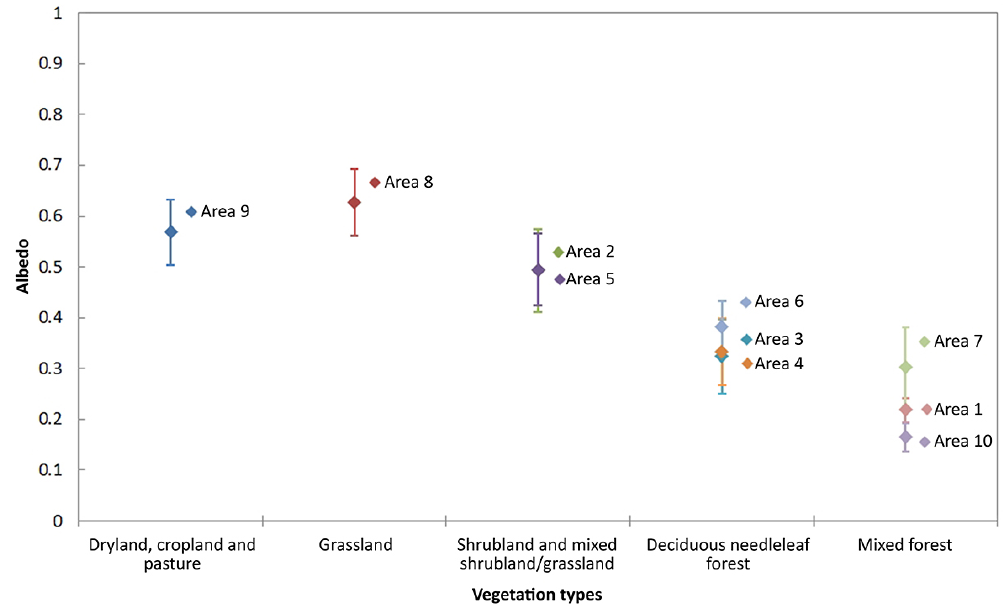
Figure 2. The MODIS white-sky albedo for total shortwave broadband averaged for winter time in 2001–2010 (dots) and corresponding standard deviation (bars) when snow cover fraction equals 100%. Descriptions on the areas are provided in Fig. 1 and Table 2.